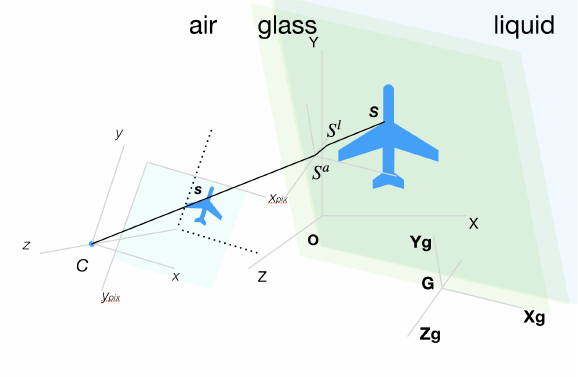
Figure 4. Light ray path for the case of two media interfaces The ray path for an image point s in this case contains three seg- ments defined by vectors (cid:126)l,(cid:126)g,(cid:126)a determining direction of the ray in liquid, glass and air correspondingly.